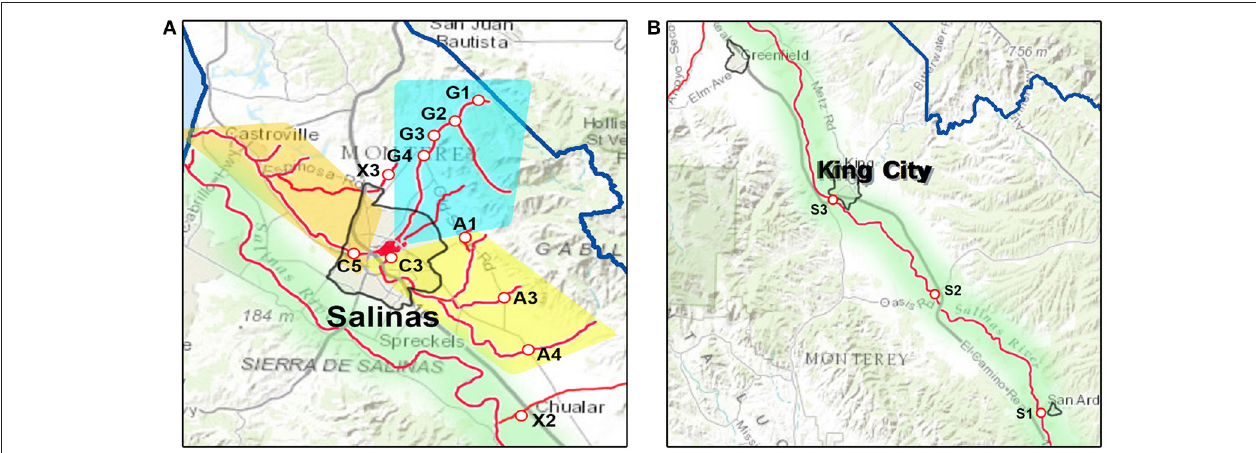
FIGURE 1 | Maps of sampling sites and watersheds in Monterey County, including; (A) , sampling sites near the city of Salinas and (B) , sampling sites near King City. The waterways are marked as redlines. The sampling sites are labeled with a letter corresponding to the watershed to which they have been assigned and a number to differentiate between sites within that watershed. A, Alisal Creek; C, Carr Lake; G, Gabilan Creek; S, Salinas River, X, extraneous (no designated